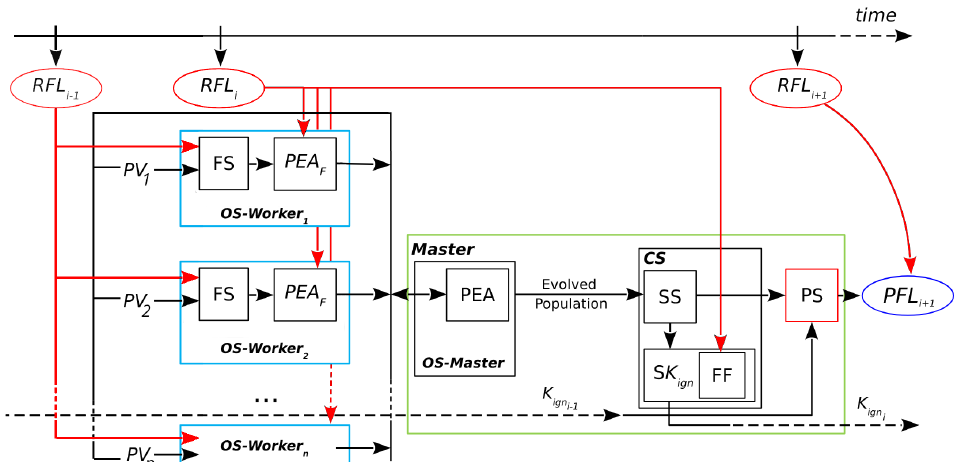
Figure 2. Evolutionary Statistical System. RFL i : real fire line of instant t i ; OS-Master : Optimization Stage in Master; OS-Worker { 1 ... n } : Optimization Stage in Workers 1 to n ; FS : fire simulator; PEA : Par- allel Evolutionary Algorithms; PEA F : Parallel Evolutionary Algorithm (fitness evaluation); PV { 1 ... n } : parameter vectors (scenarios); CS : Calibration Stage; SS : Statistical Stage; SK ign : Key Ignition Value search; FF : fitness function; K ign : Key Ignition Value for t i ; PS : Prediction Stage; PFL i + 1 : predicted i fire line of instant t i + 1